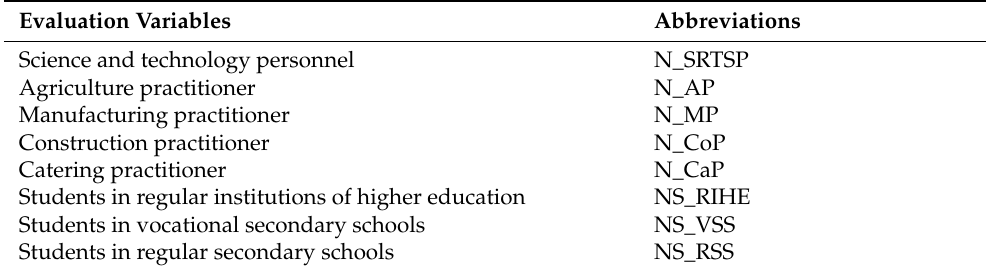
Table 1. Evaluation variable of inferiority. Unit: Number of